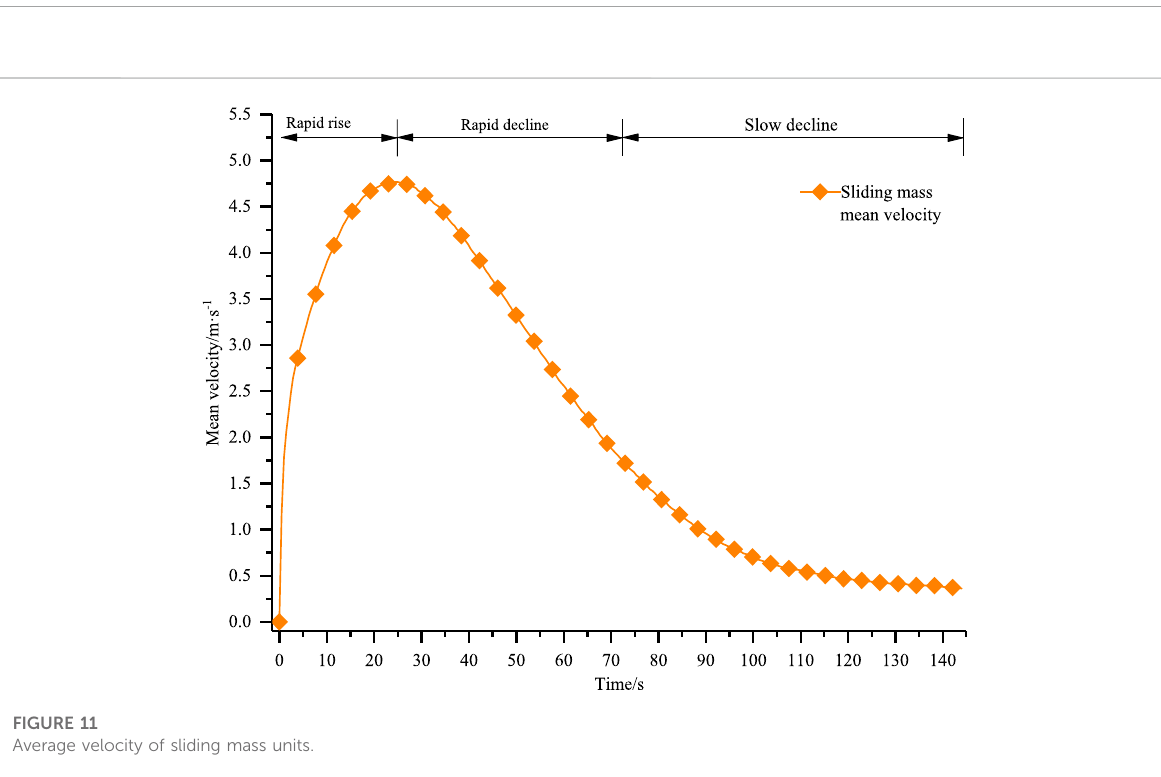
FIGURE 11 Average velocity of sliding mass